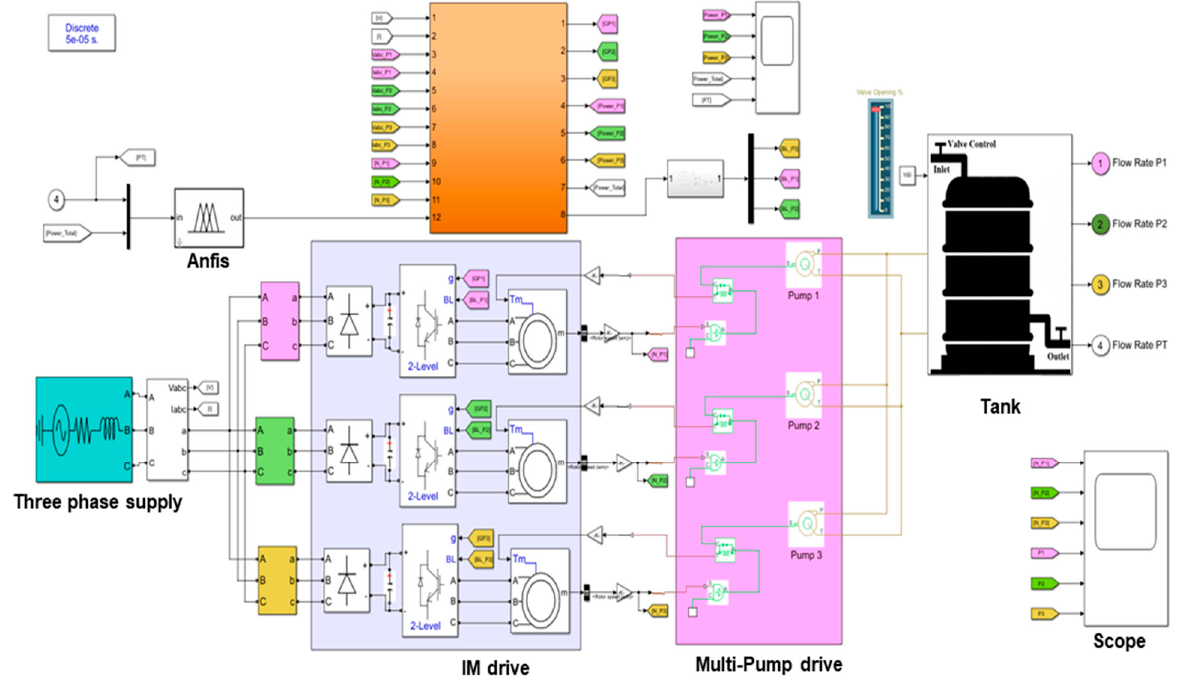
Figure 8. Simulation model of the pumping structure.